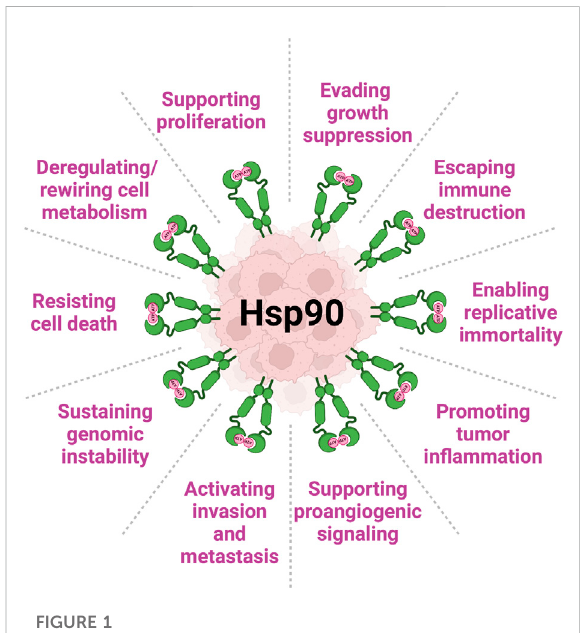
FIGURE 1 Heat shock protein 90 (Hsp90) is complicit in all Hallmarks of Cancer (per (Hanahan and Weinberg, 2011; Hanahan, 2022)). Levels of Hsp90 (both intracellular and extracellular) are signi fi cantly increased in cancer. In this review, we present several examples of Hsp90 involvement in key mechanisms of cancer initiation, development and